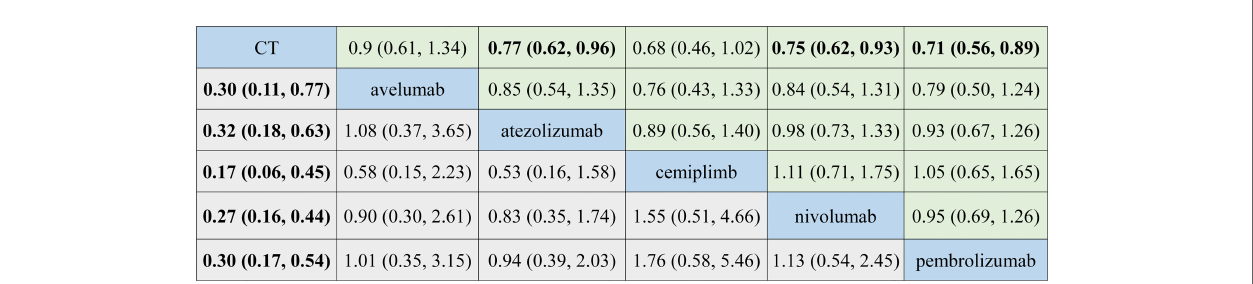
FIGURE 3 | Summary for target outcomes including overall survival (OS) and treatment-related adverse events (TRAEs). The upper right section presented results for OS, and the left bottom section showed the results for TRAEs. The number in each cell represented the result that the treatment in the upper left cell divides that treatment in the lower right cell. Bold number indicates statistical signi fi cance.